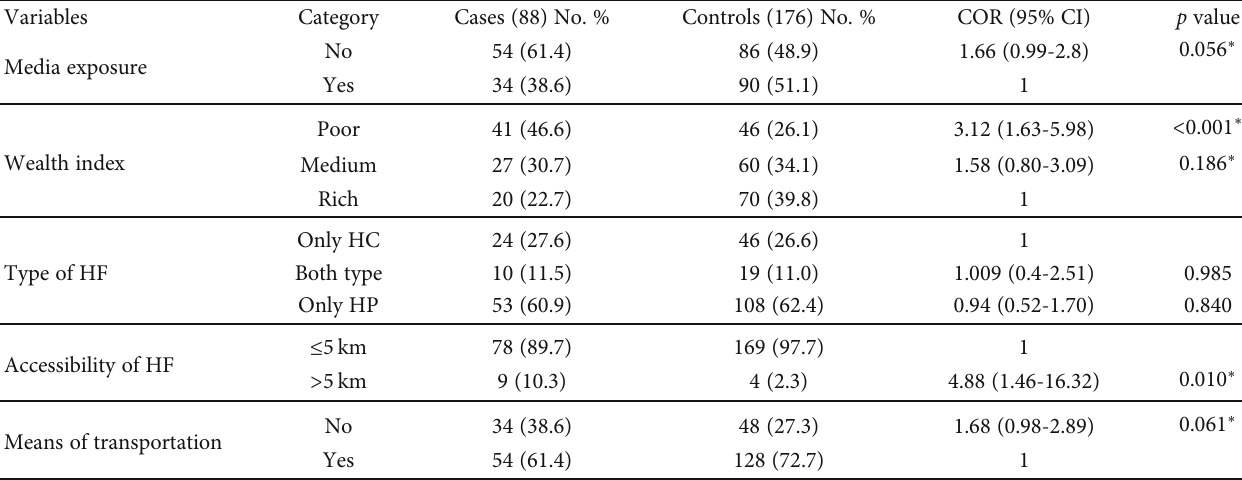
Table 3: Bivariate analysis of socioeconomic and health service-related factors of cases and controls in Abobo Woreda, Gambella region, Southwest Ethiopia,